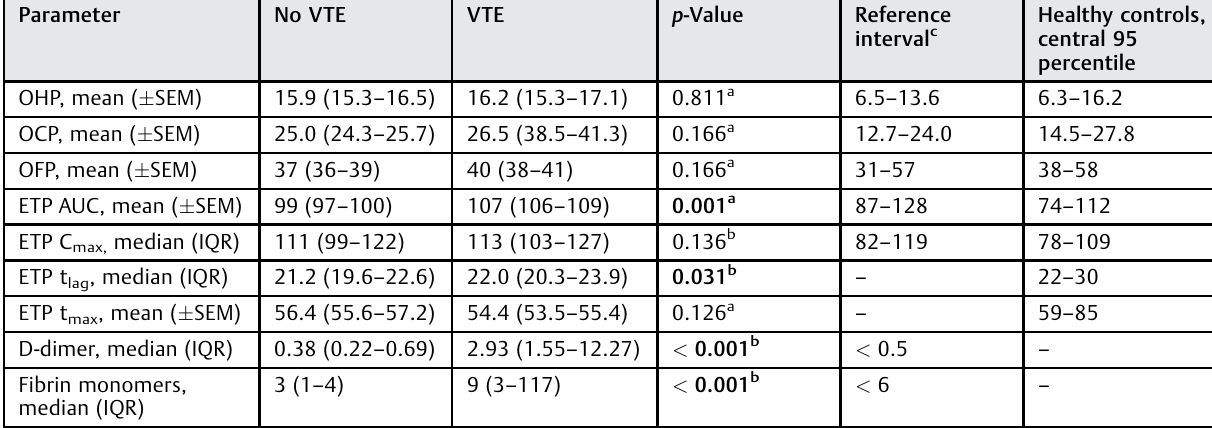
Table 2 Assay results and signi fi cant differences between patients with and without VTE Parameter No VTE